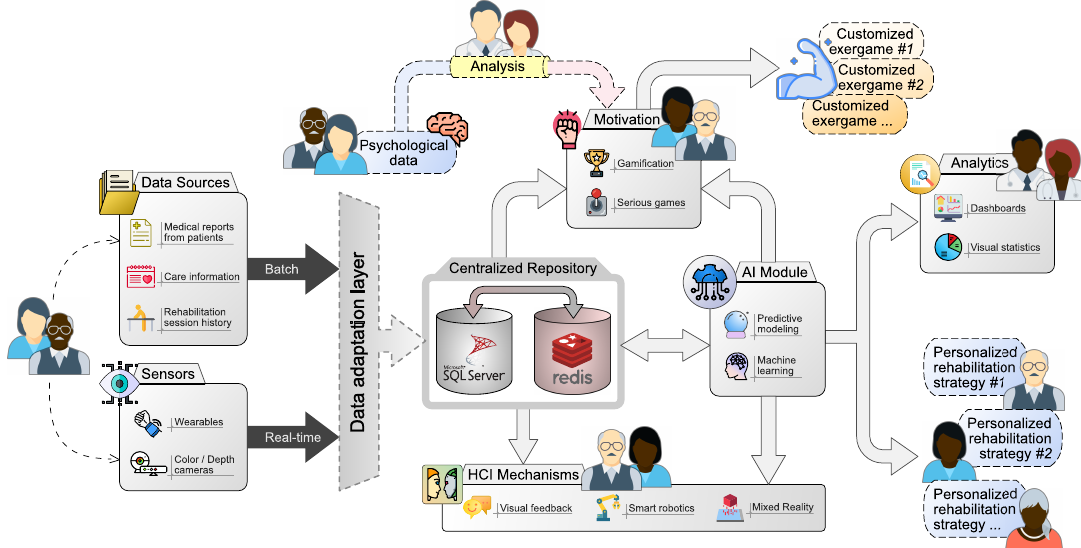
Figure 2. General overview of proposed architecture for precision